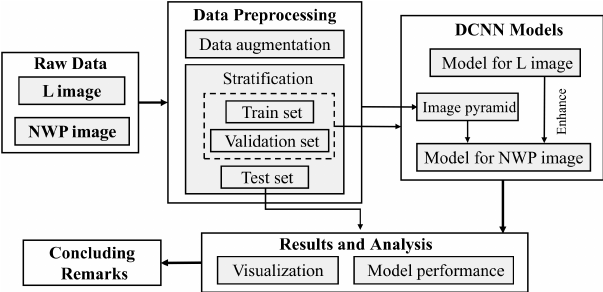
Figure 1. Flowchart of the